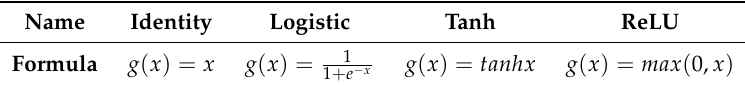
Table 1. Most common activation